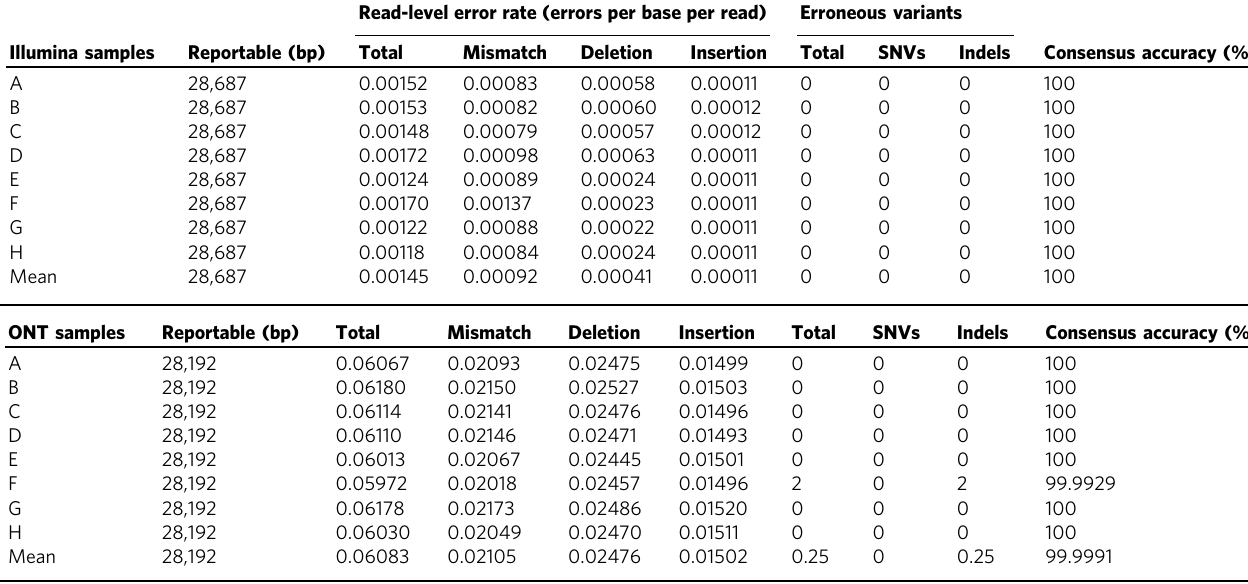
Table 1 Sequencing accuracy for Illumina and ONT whole-genome sequencing of synthetic SARS-CoV-2 controls. Read-level error rate (errors per base per read)